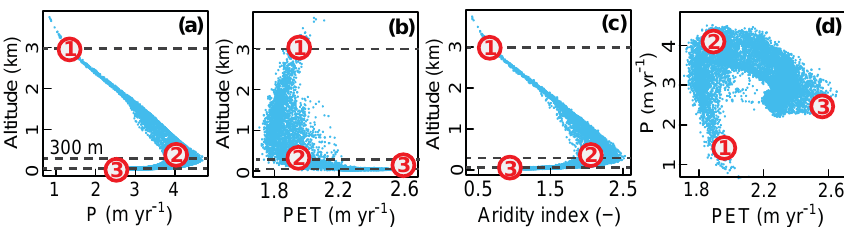
Figure 11. Variation of precipitation ( P ), potential evapotranspiration (PET), and aridity index ( P /PET) with altitude in a 1 ◦ by 1 ◦ grid cell of the Himalayas in the extent of Fig. 4 (89–90 ◦ E, 26–27 ◦ N). P and PET for sites 1, 2, and 3 in Fig. 10 are marked in the graphs. Between locations 3 and 2, P and aridity index increase and PET decreases with altitude. Between points 2 and 1, P and aridity index sharply decrease and PET slightly increases with